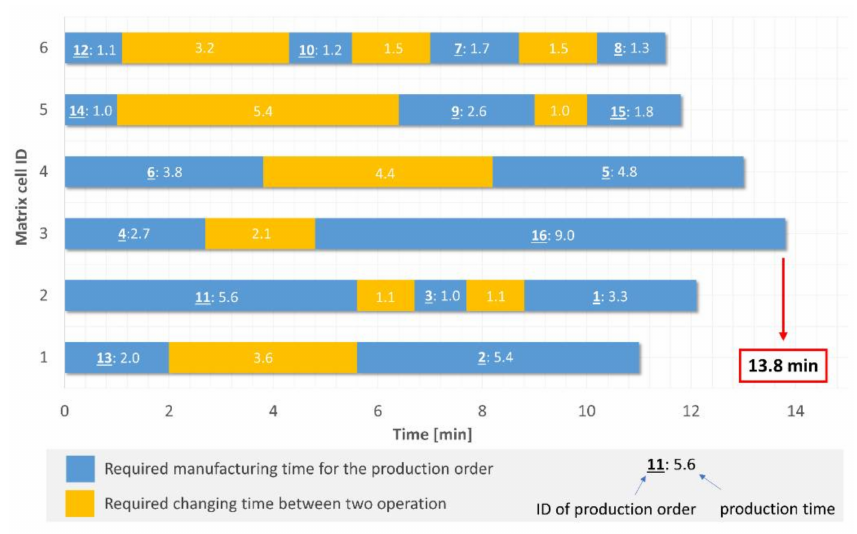
Figure 5. Gantt chart of the working process resulting from the optimal assignment of production orders to matrix cells in scenario